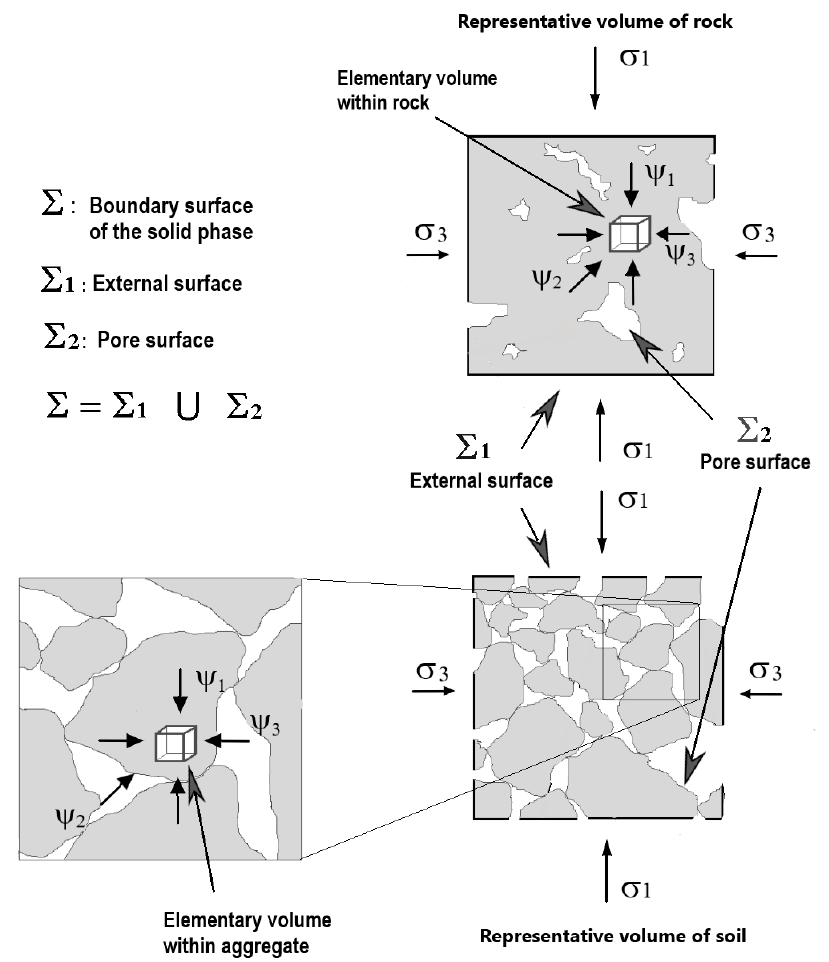
Figure 2. Representative and elementary volume in porous media considered in this study. Remote stress acting over a two-phase porous medium and local stress tensor within the solid